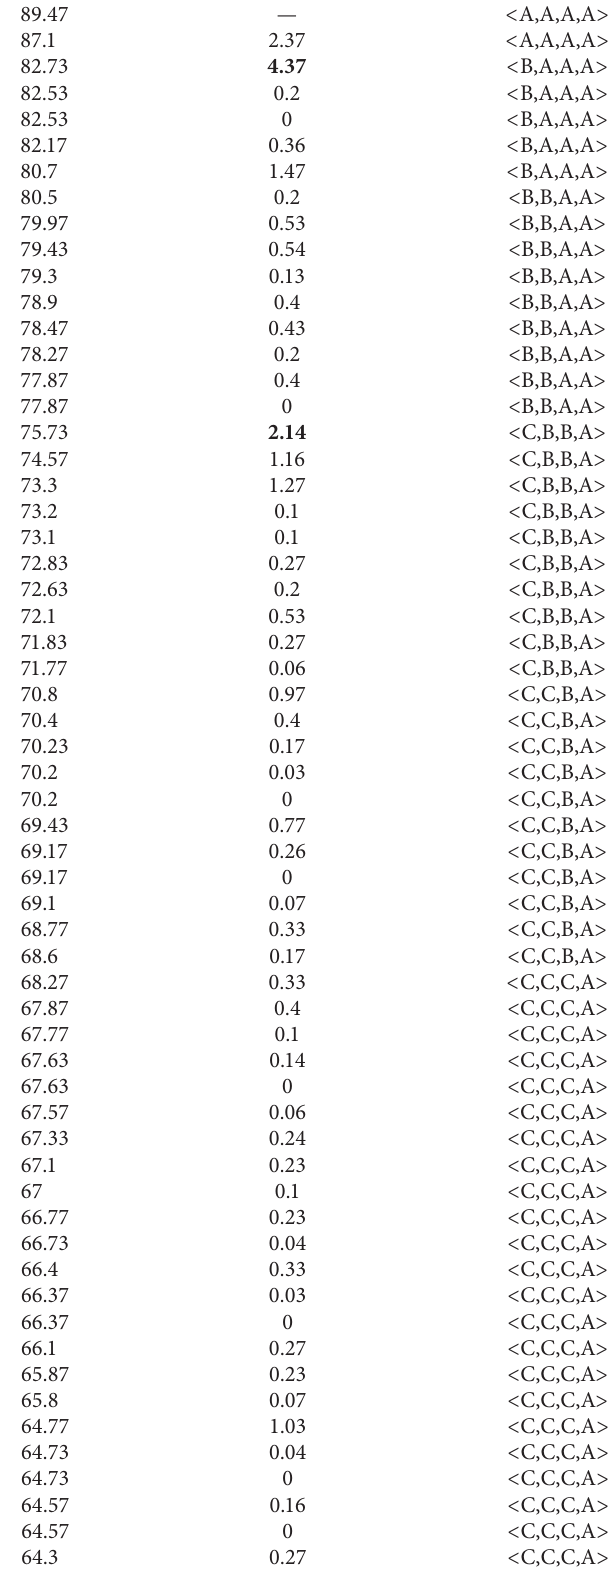
Table 11: Grading results of RD+. Score Gap